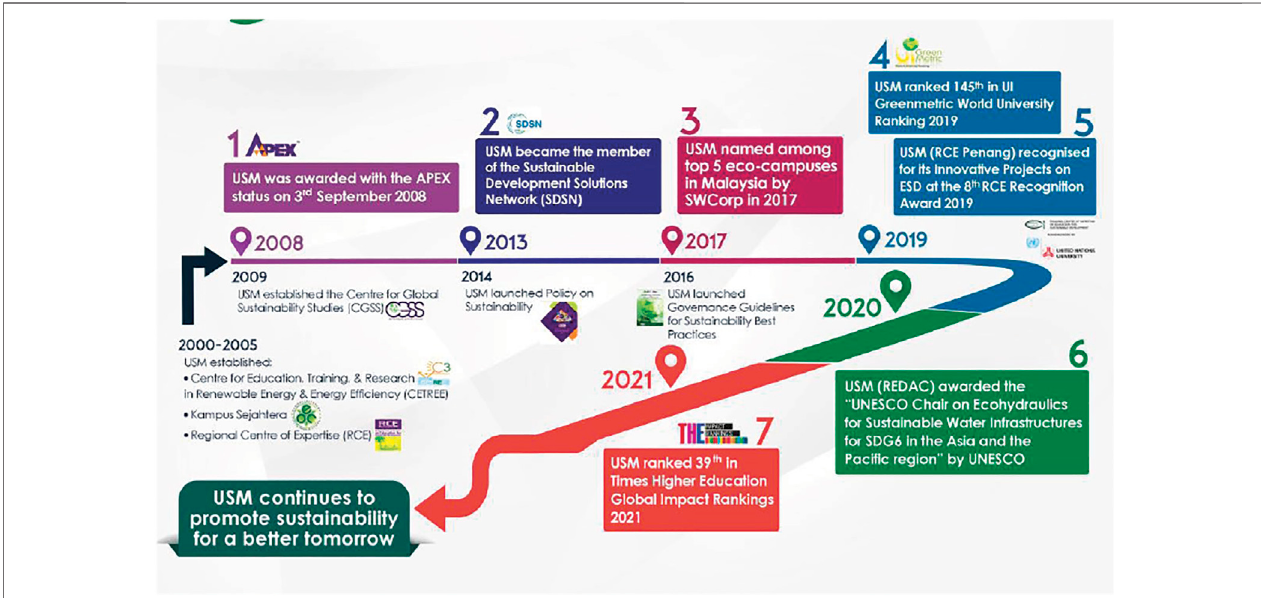
FIGURE 4 | The sustainability journey in a public Malaysian university.